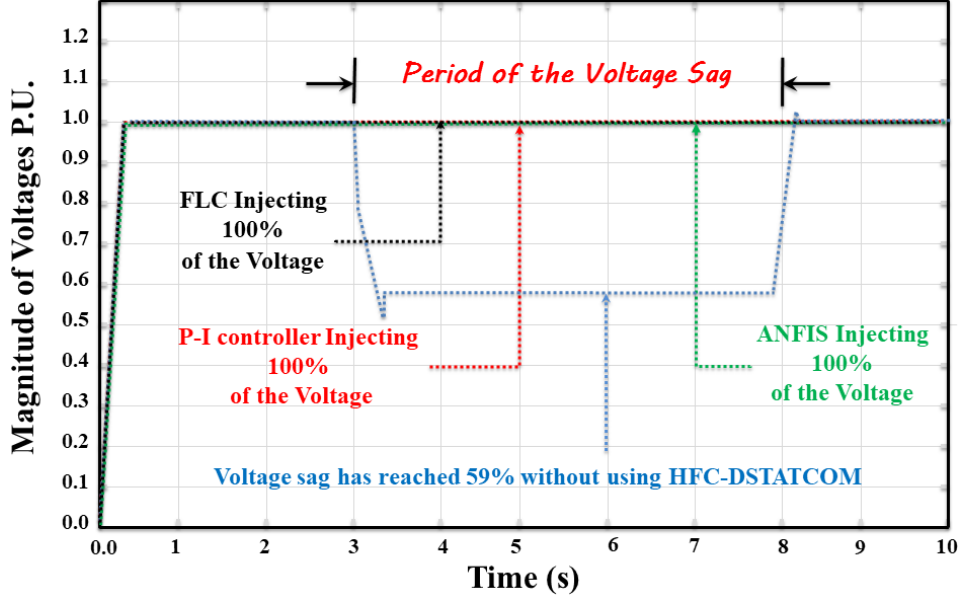
Figure 19. Injection voltage by HFC D-STATCOM due to Single Line-to-Ground Faults Scenario. The approaches controller shows that DNS voltage sag occurs from 0.3 s up to 0.8 s. The voltage sag has reached 0.59 (p.u). due to the two line-to-ground faults scenario. HFC D-STATCOM is utilized in the feeder and values of injection voltage reach 100% at a single line-to-ground faults scenario utilizing the P-I controller, FLC, and ANFIS. It is observed that the single line-to-ground of DNS has improved dramatically since the operation of the HFC D-STATCOM. Figure 20 illustrates the injection voltage by HFC D-STATCOM due to the double line-to-ground faults scenario.